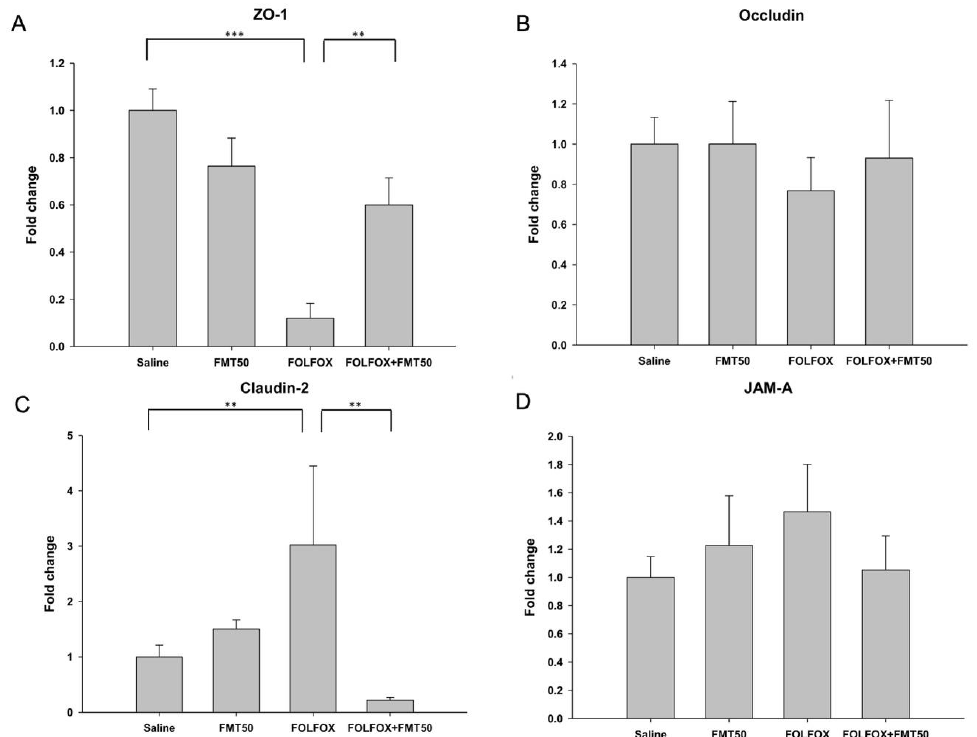
Figure 4. Tight junction mRNA expression levels in the jejunum of subcutaneously injected colorectal cancer mice exhibiting FOLFOX-induced intestinal damage with/without FMT ( n = 6 for each group). Relative mRNA expression levels of the tight junction molecules ( A ) ZO-1, ( B ) occludin, ( C ) claudin-2, and ( D ) junctional adhesion molecule-A (JAM-A) were determined by qPCR in jejunum tissues. FMT50: 50 mg/mL. Values are presented as the mean ± SEM. **: p < 0.01, ***: p < 0.001.